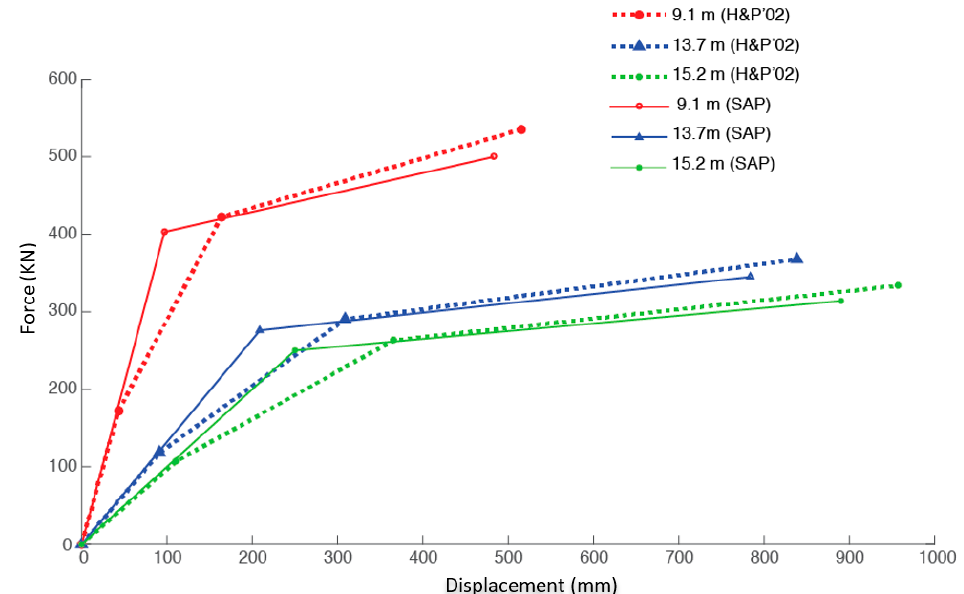
Figure 6. Comparison of pushover curves from SAP2000 and from Hewes and Priestly [28] model for the three columns after calibration.